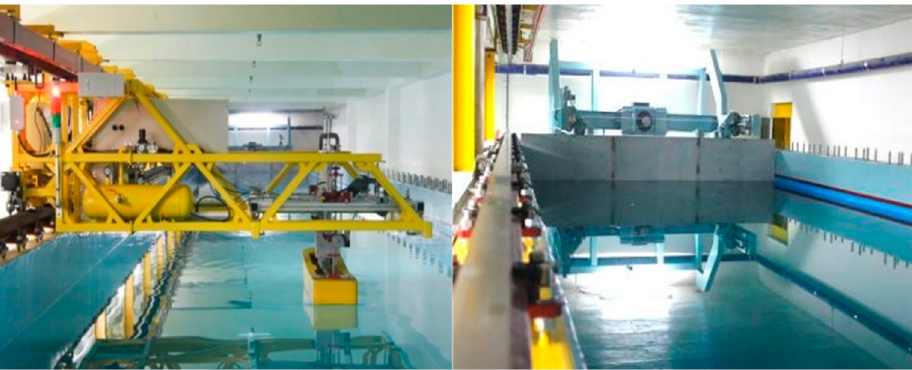
Figure 3. The towing tank in Inha University .